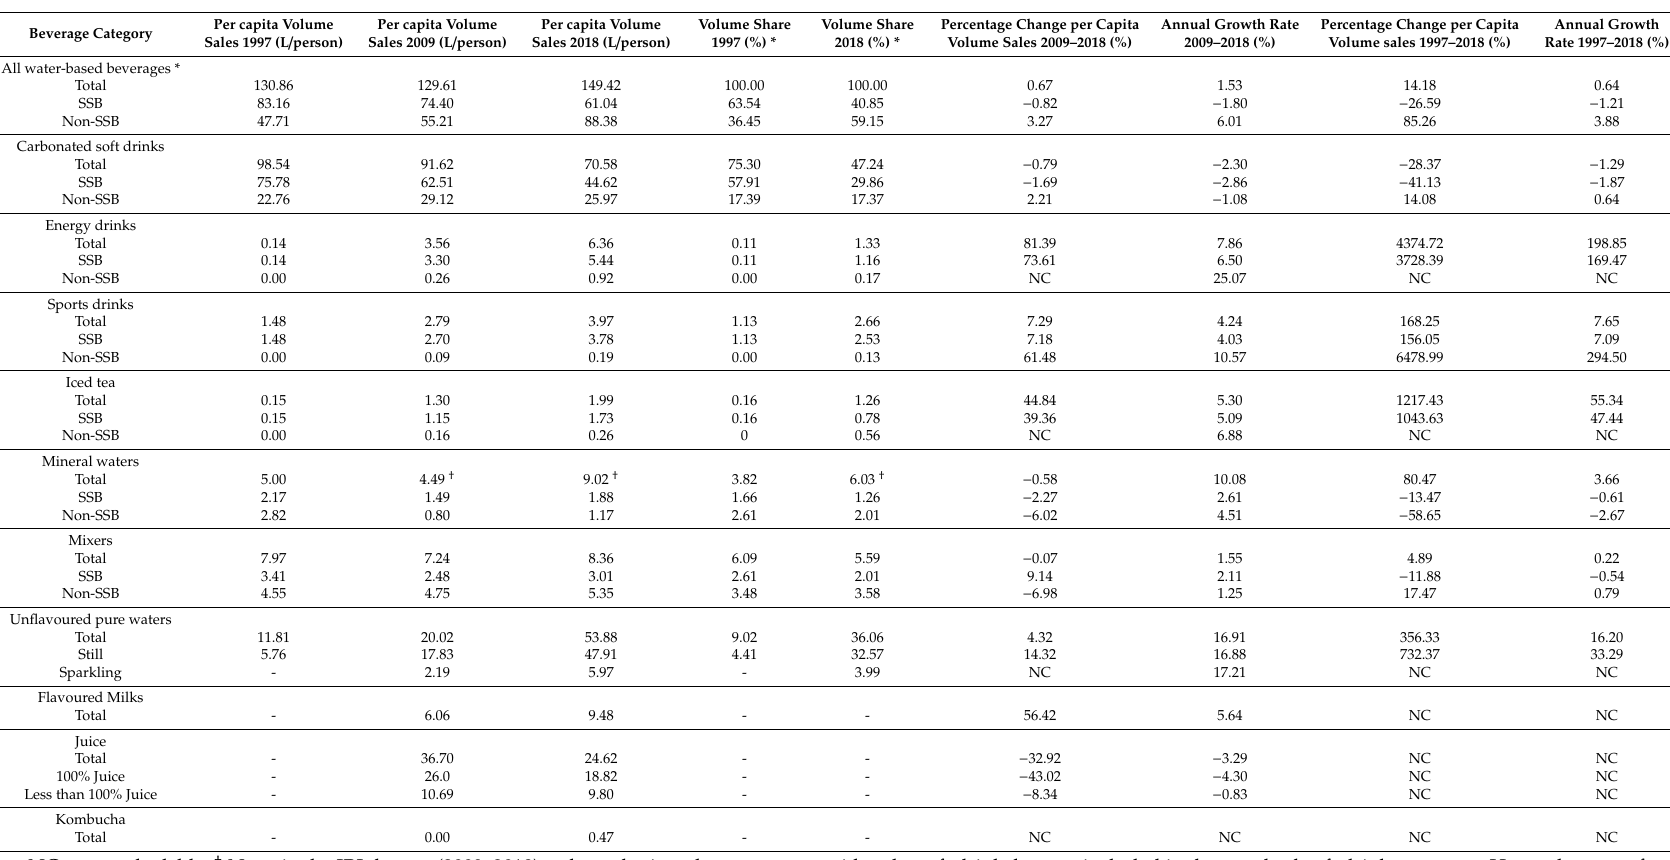
Table 1. Trends in volume sales of water-based beverages between 1997 and 2018. * Total may not equal sum of SSB and non-SSB categories due to rounding error. BeverageCategory Allwater-basedbeverages* Total